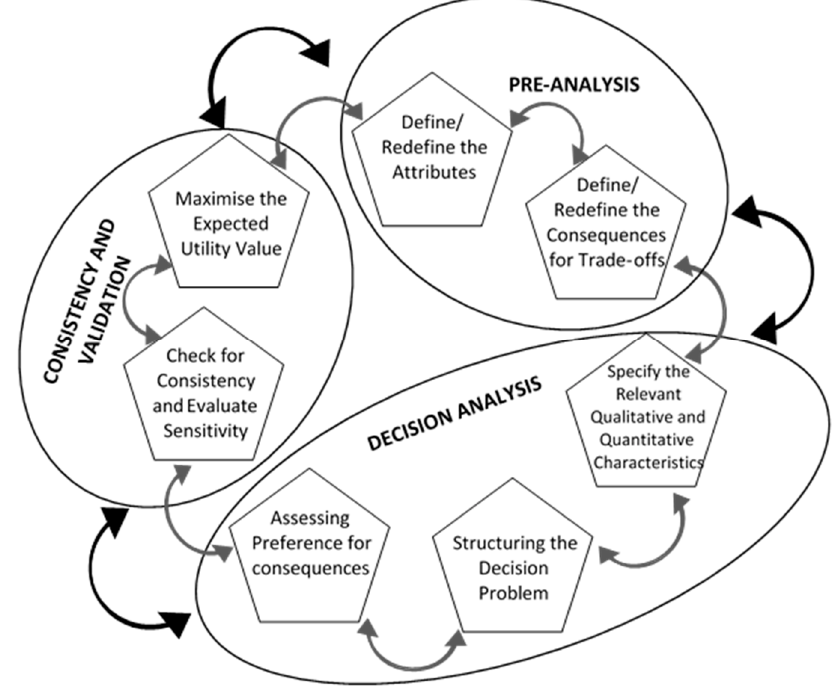
Figure 7. The generic utilitarian decision-making structure.